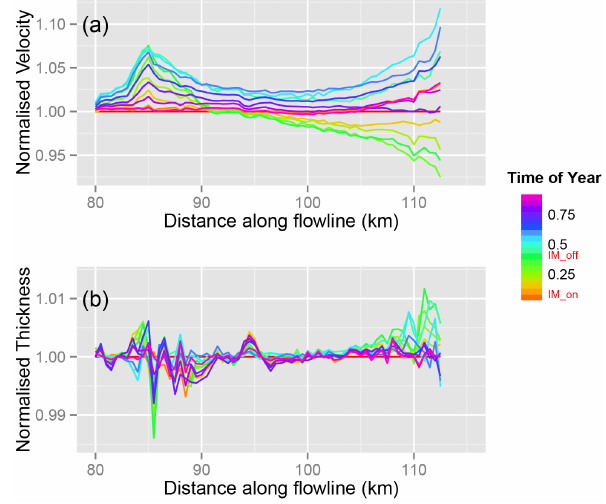
Figure 8. Plots showing velocity (a) and thickness (b) perturbations | 34 through a single calendar year. Line colour indicates time of year. Fig. 8. Plots showing velocity (a) and thickness (b) perturbations through a single calendar year. Line colour indicates time of year. Velocity and thickness have been normalised against their Jan 1st values. Velocity and thickness have been normalised against their 1 January 35